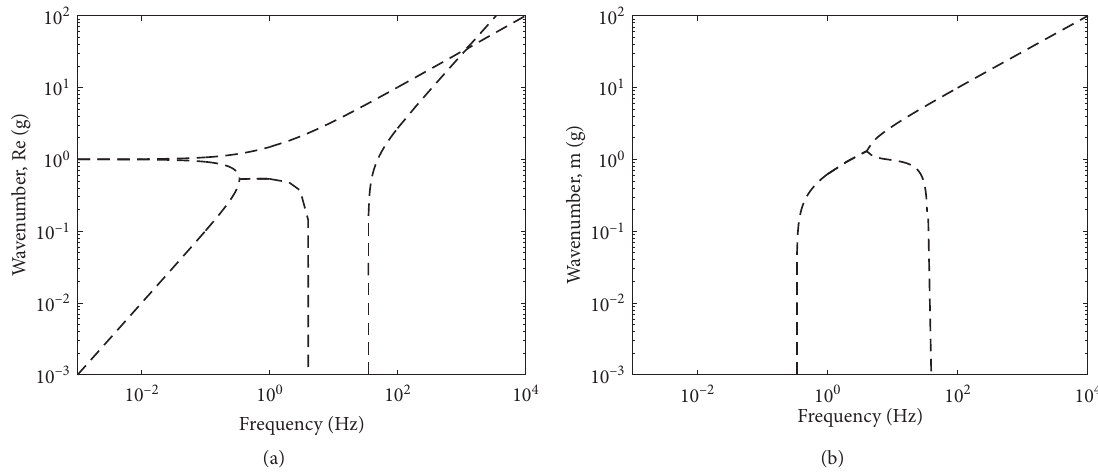
Figure 3: Frequency spectrum of a curved beam with k � 0 . 0289. (a) Real wavenumber value. (b) Imaginary wavenumber values (ex- tensional by